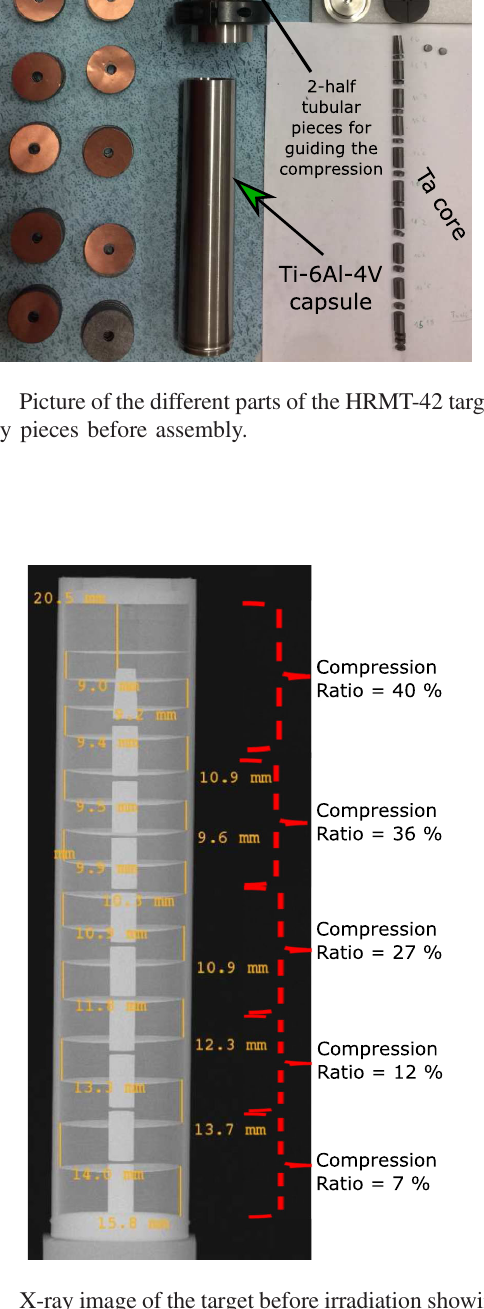
FIG. 4. X-ray image of the target before irradiation showing the Ta rods of the core and Cu foils within the EG